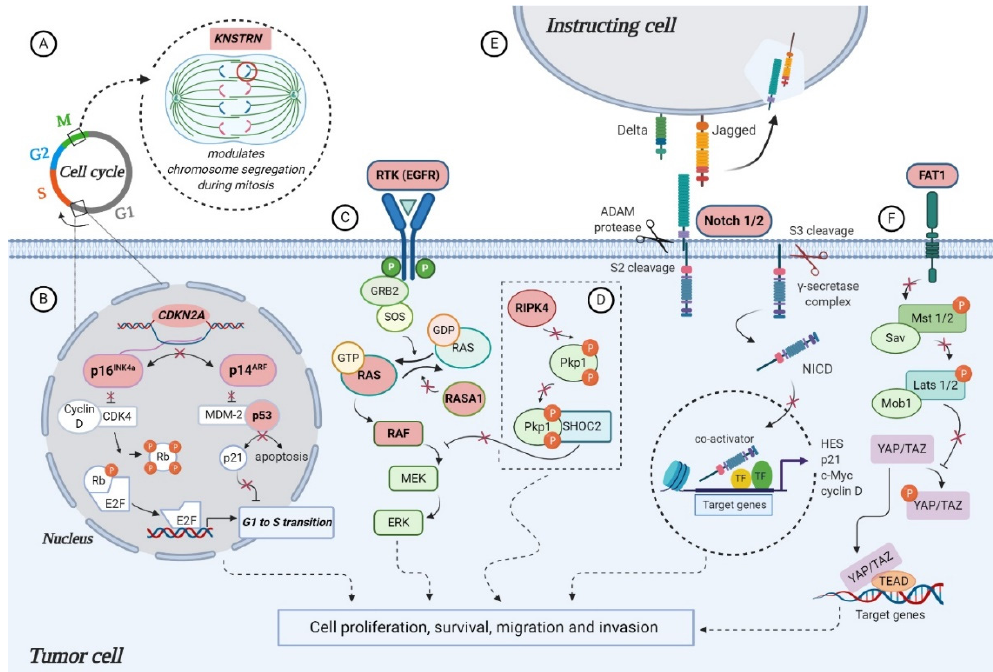
Figure 2. Molecular alterations that drive cutaneous squamous cell carcinoma (cSCC) proliferation, survival and metastasis through aberrant signaling (highlighted in pink): ( A ) alterations in KNSTRN expression promote abnormal chromosome segregation during mitosis; ( B ) CDKN2A encodes for cell-cycle regulatory proteins p16 INK4A and p14 ARF , involved in retinoblastoma (RB) and p53 pathways. loss of heterozygosity (LOH), mutations or deletions of CDKN2A leads to functional loss of: (i) p16 INK4A , which allows phosphorylation of RB by CDK4-Cyclin D complex and release of E2F transcription factors, that can then transcribe S phase promoting genes; (ii) p14 ARF , which allows MDM-2 to bind p53 and inhibit apoptosis; ( C ) activating mutations in EGFR , RAS and RAF or inactivation of negative regulator RASA1 promotes cell proliferation and survival through constitutive activation of MAPK pathway; ( D ) proposed model for RIPK4 action in skin carcinogenesis that depicts the phosphorylation of PKP1 by RIPK4, which promotes binding to sca ff old protein SHOC2 and blocking of RAS / MAPK signaling. In the absence of functional RIPK4, the complex cannot assemble and the signaling pathway remains active, thus facilitating cSCC development; ( E ) the inactive precursor is cleaved in the Golgi by a furin-like convertase (S1 cleavage) and translocated into the cell membrane, where binding of a NOTCH ligand (Delta, Jagged) to the receptor induces the second cleavage (S2) by a member of the disintegrin and metalloproteinases (ADAM) family. This results in the formation of a membrane-tethered NOTCH truncated fragment, which is further cleaved (S3) by a presenilin-dependent γ -secretase